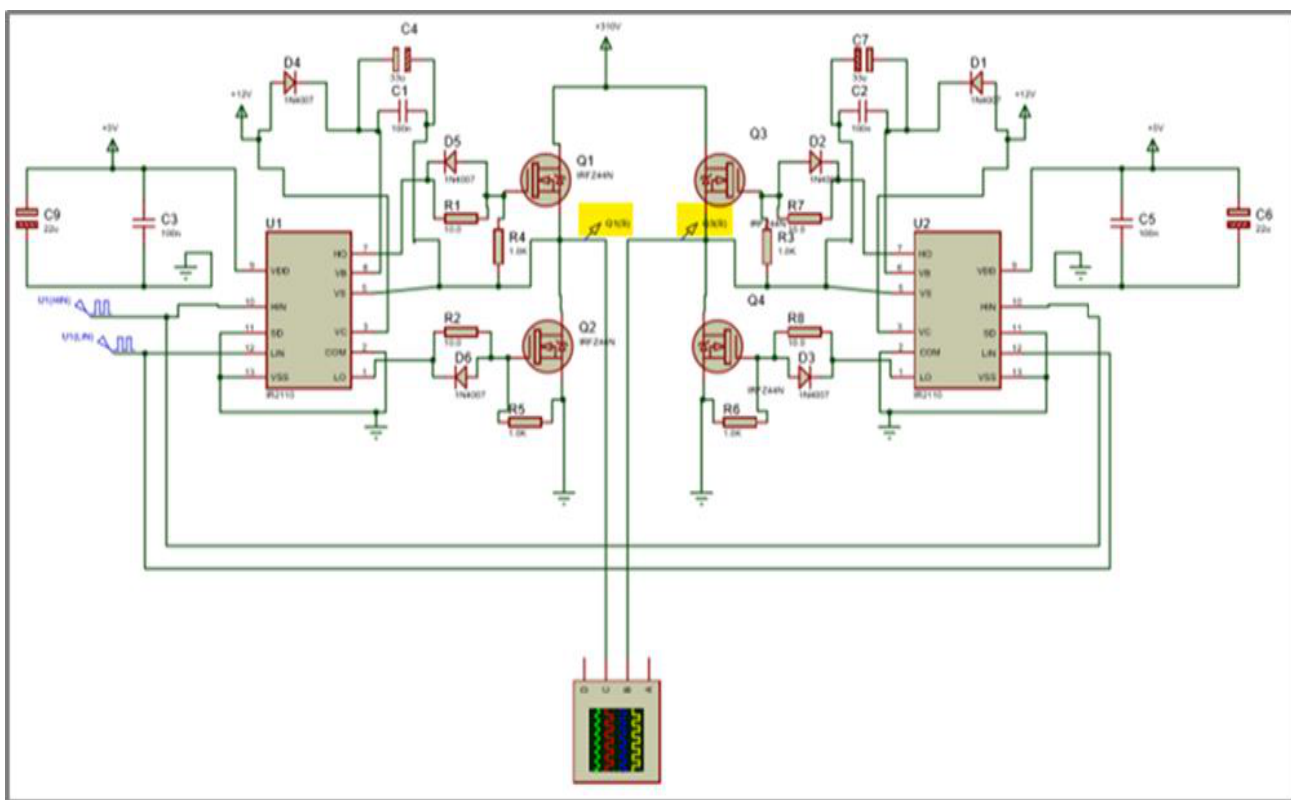
Figure 8. Implementation of H-bridge voltage source inverter using Proteus VMS.